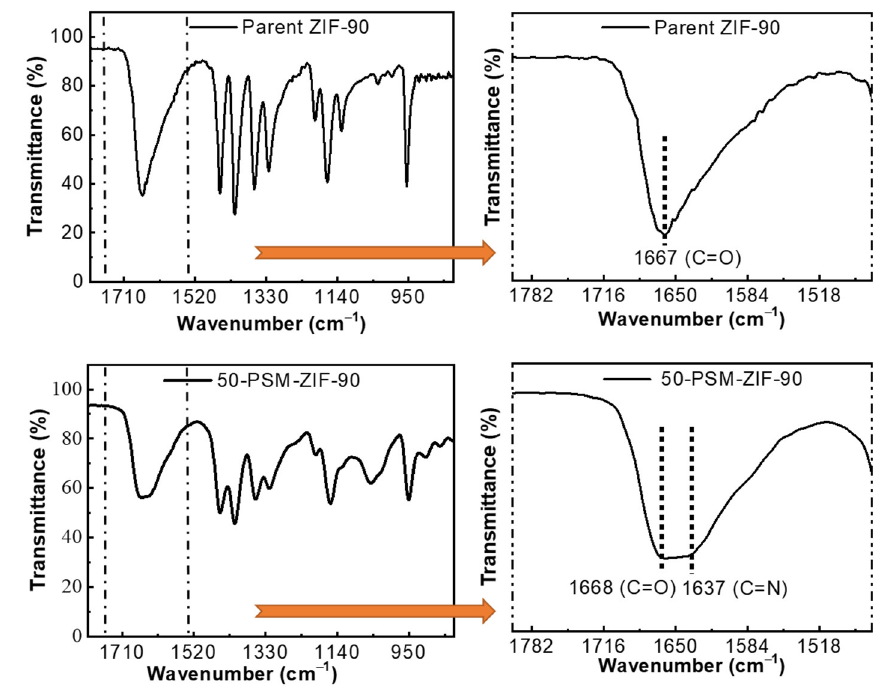
Figure 5. FT-IR spectra of parent ZIF-90 and 50-PSM-ZIF-90.